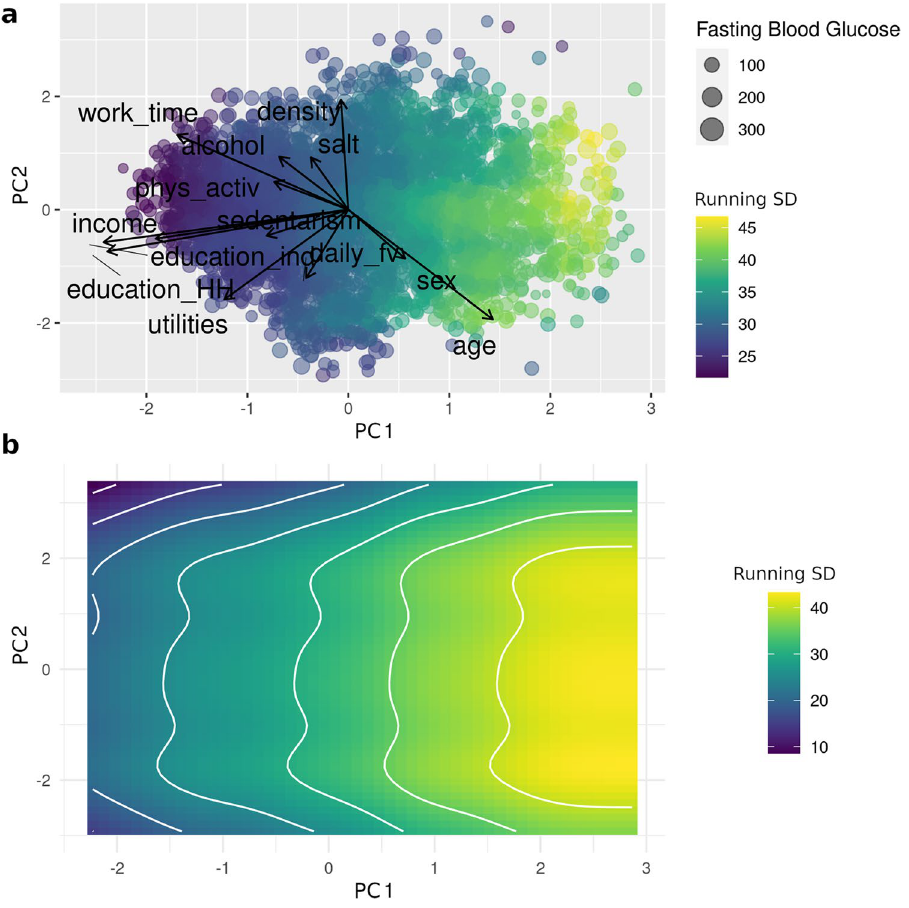
Figure 3. Running standard deviation for fasting glycemia in the first and second components of the PCA. ( a ) Biplot for the first and second components of the PCA; point size correlates with fasting blood glucose levels (mg/dL) and color scale indicates levels of running standard deviation (mg/dL). ( b ) GAM smoothed curves for the running standard